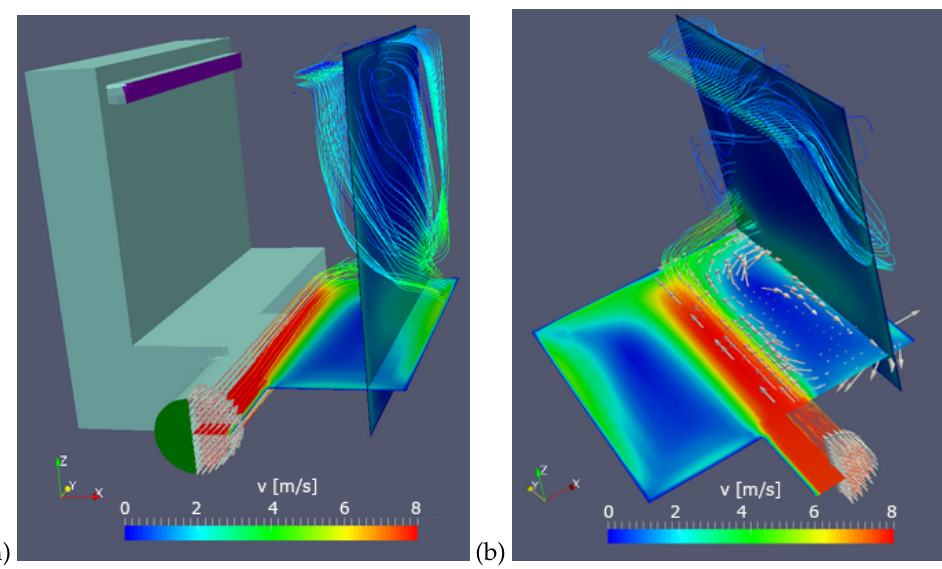
Figure 6. The 3D flow distribution duct: geometry and boundary conditions ( a ), streamlines and contour plots revealing flow features ( b